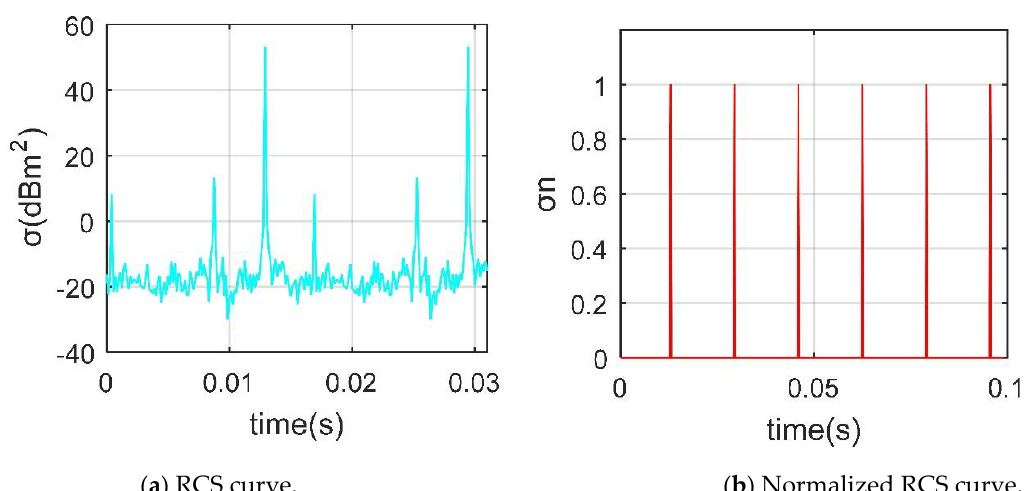
( a ) RCS curve. ( b ) Normalized RCS curve. Figure 16. RCS of the rotor 1, α = 27°, β = 0°, A df = A dr = 0°, f RH = 10 GHz, V m = 0 m/s, n r1 = 1200 r/min.